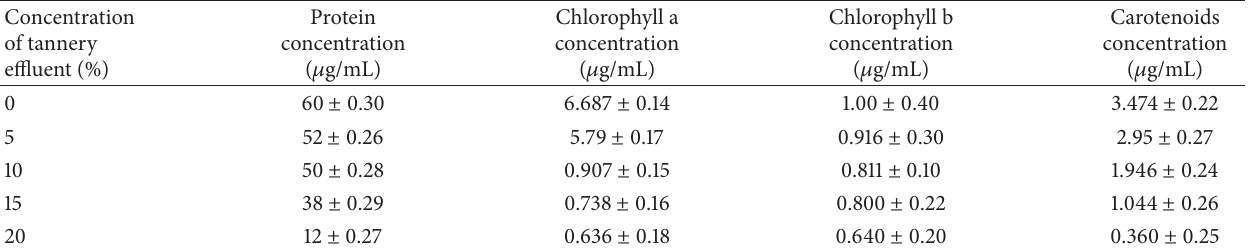
Table 5: Effect of tannery effluent on protein content and photosynthetic pigments of Lemna minor (all values are mean ± SD range for three observations each).